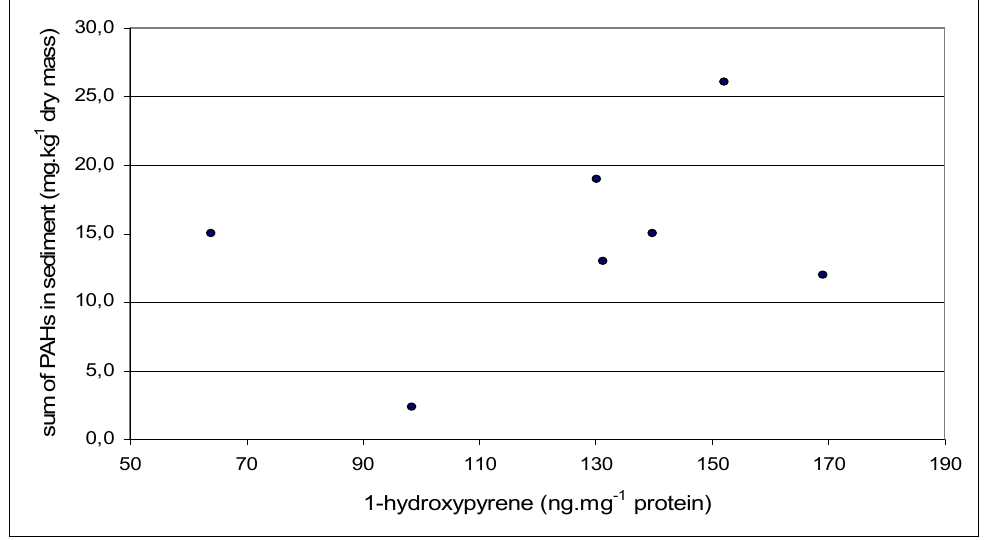
Figure 7. Correlation between content of biliary 1-OHP and PAH in sediment in May ( r = 0.68, P > 0.05).